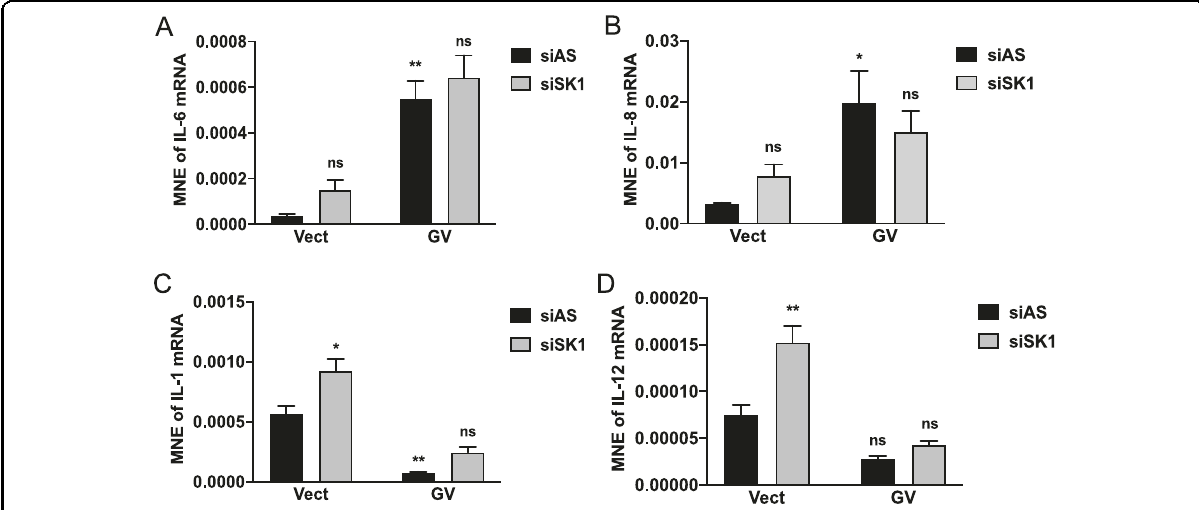
Fig. 5 SK1 knockdown does not affect major components of the senescence-associated secretory phenotype induced by oncogenic K-Ras overexpression. A – D Analysis of expression of cytokines and chemokines at mRNA levels by RT-qPCR in cells overexpressing Vect or GV K-Ras that have been transfected with control (AS) or SK1 siRNA (20 nM) for 72 h. TaqMan probes for IL-6, IL-8, IL-1, and IL-12 were used and Actin was used as a control gene. The mean normalized expression of each mRNA was determined by using the Ct values ( N = 3, data are presented as mean ± SEM, two-way ANOVA with Tukey ’ s multiple comparisons test, * means p < 0.05 comparing the group tested to Vector control siRNA, # means p < 0.05 comparing the group tested to GV control